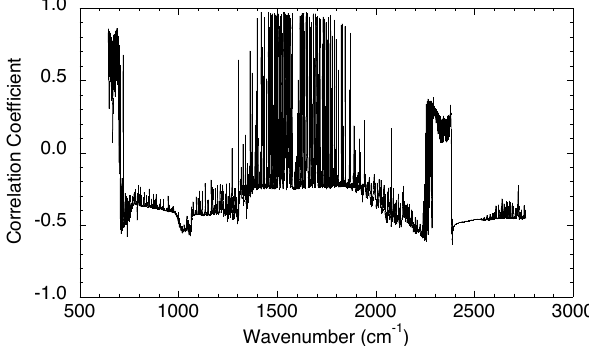
Figure 1. Linear correlation coefficients between the radiances at 25.25cm − 1 and the rest of the spectrum. Data are simulated by the LBLRTM from Phillips